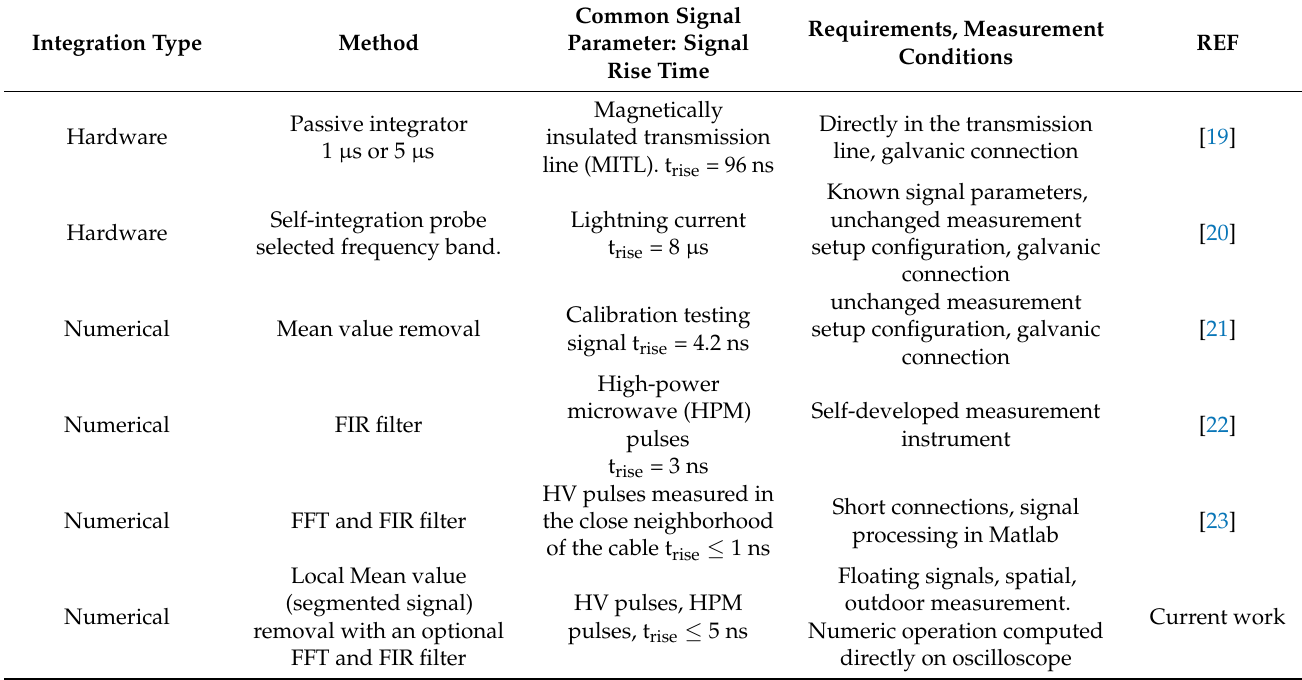
Table 1. Integration methods